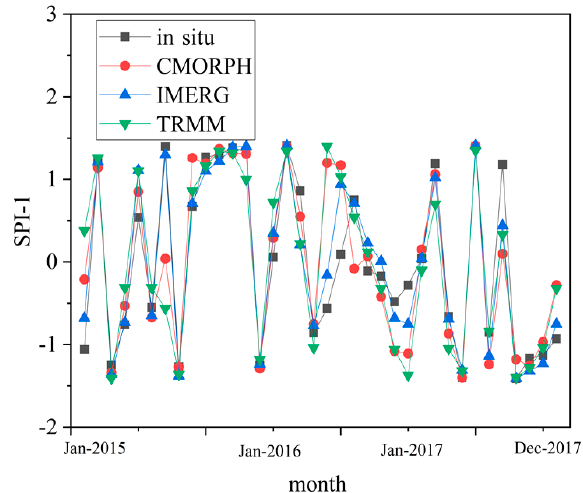
Figure 9. Temporal comparison of 1-month SPI values between satellite-based precipitation products and in situ observations.